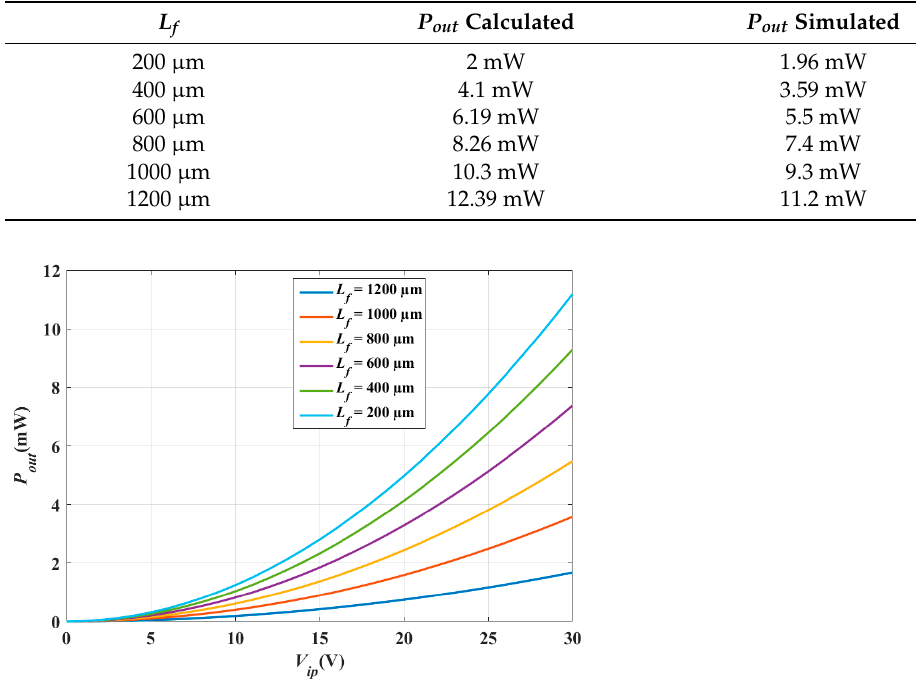
Figure 11. P out versus V ip at different L f .